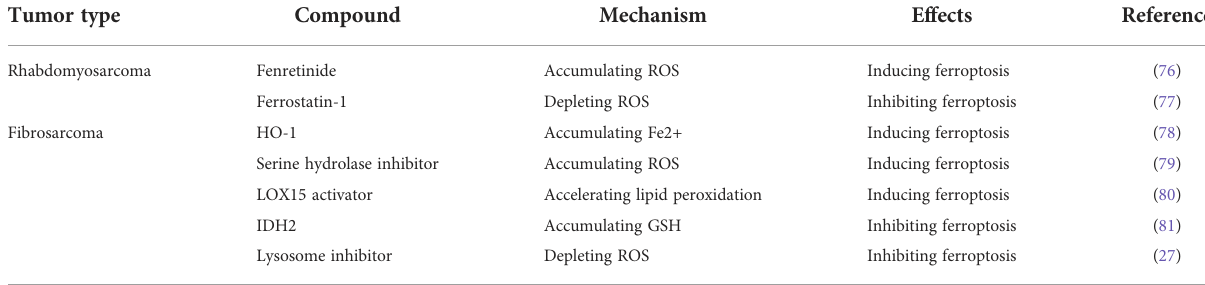
TABLE 2 Ferroptosis-related in other types of musculoskeletal